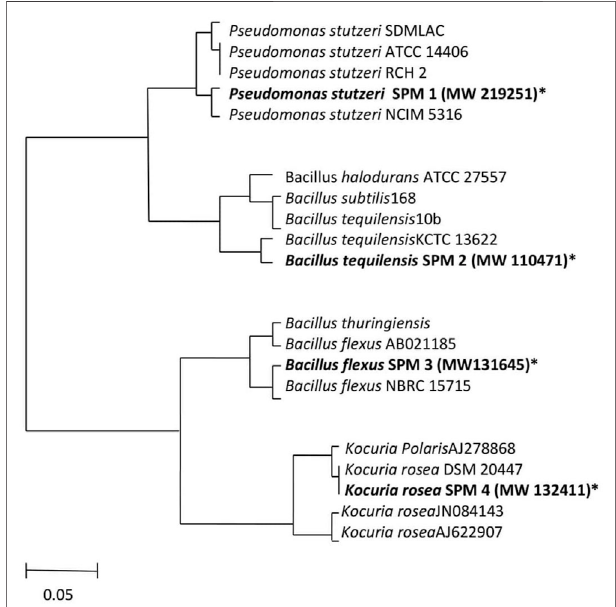
FIGURE 1 | The evolutionary history was inferred using the Neighbor- Joining method. The evolutionary distances were computed by the Maximum Composite Likelihood method. The units of the number of bases substituted persite.Themissingdataandthepositionsthathadgapswereremoved from the database (Complete deletion option). For conducting the phylogenic analyses MEGA4 was used. A 5% divergence is presented in the scale bar.